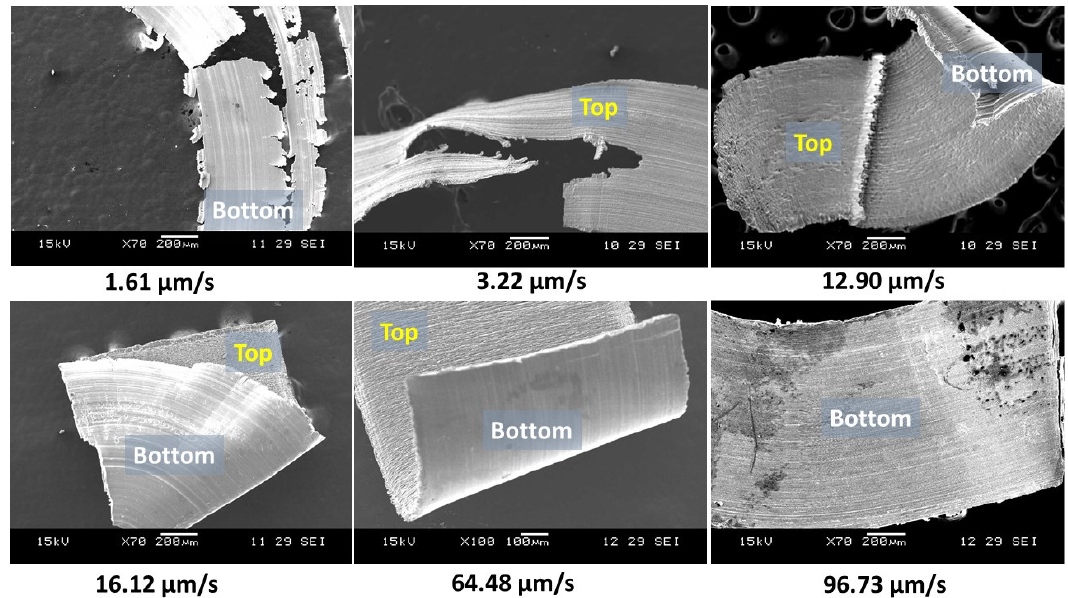
magnification of the SEM image. Thus, material deformation is the perceived characteristic of chip formation at small feed rate. On the other hand, free surface of Al alloy chip at a large feed rate (96.73 μ m/s) shows lamella-like structure typically produced by shearing mechanism [56], as shown in Figure 6b at ×10,000 magnification of the SEM image. Figure 4. Varying microchip morphology observed through scanning electron microscope (SEM) image analysis.